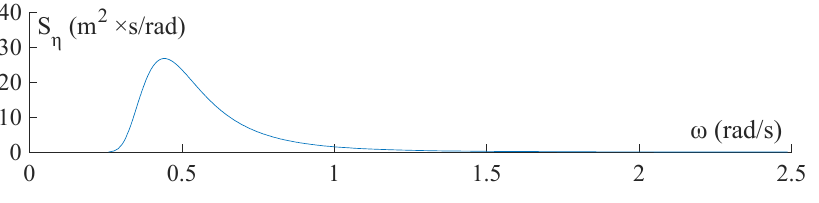
Figure 6. Power spectrum density function of the wave surface elevation.